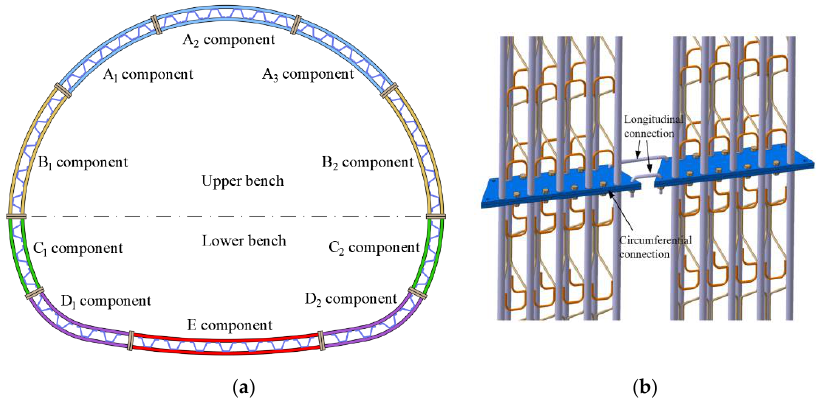
Figure 16. Division scheme and joint connection of the spatial reticulated grid structure. ( a ) Arch joint distribution and ( b ) joint connection types.